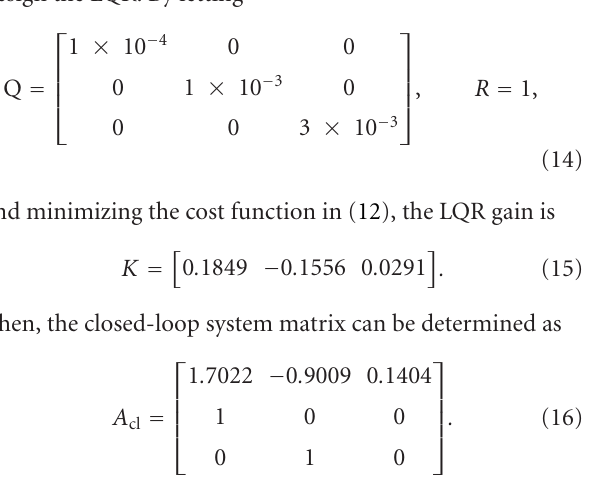
Figure 5: Pole-zero plot for nonminimum EHA